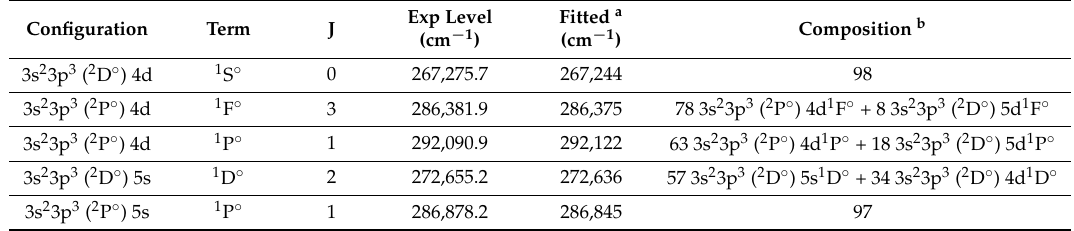
Table 1. New Ar III energy levels.